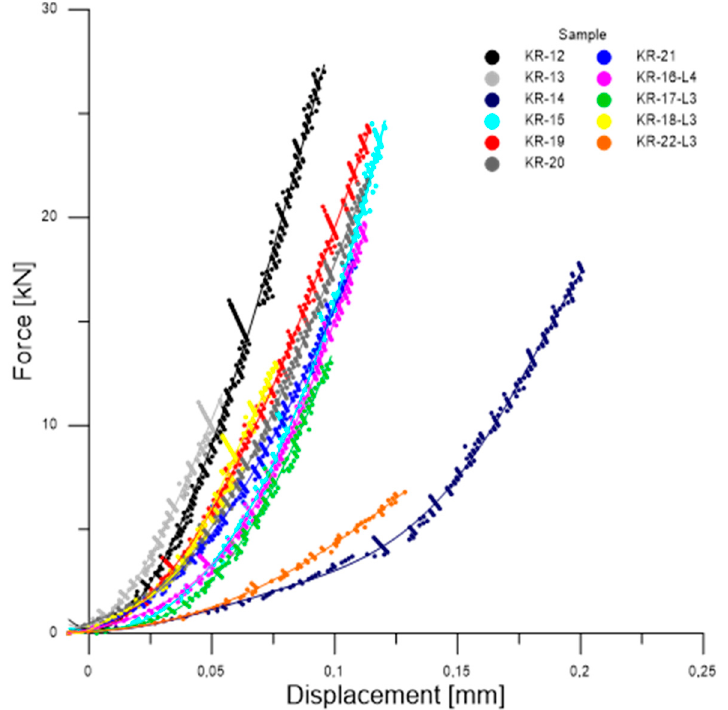
Figure 3. Series of Brazilian tests for 10 dolomite samples.